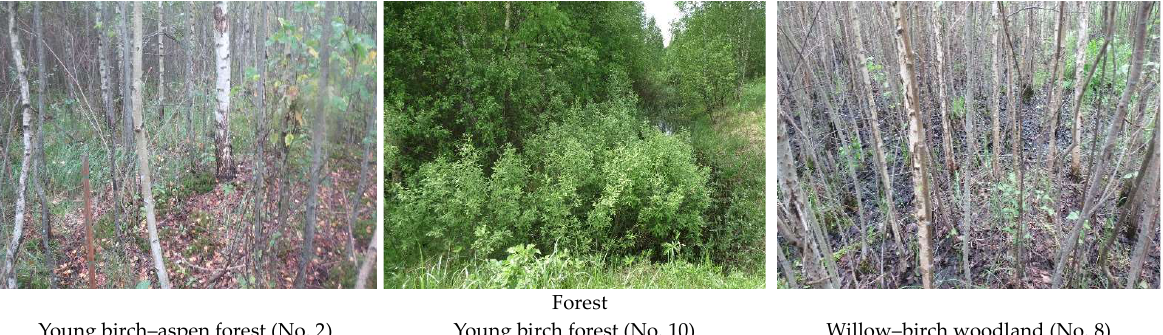
Figure 3. Characteristic types of plant communities represented in the studied peatlands. The numbers in-dicate the monitoring